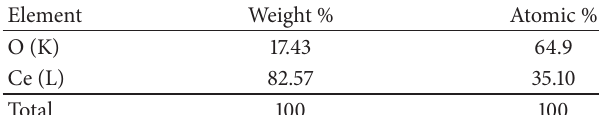
Table 1: EDS analysis of cerium oxide nanoparticles.